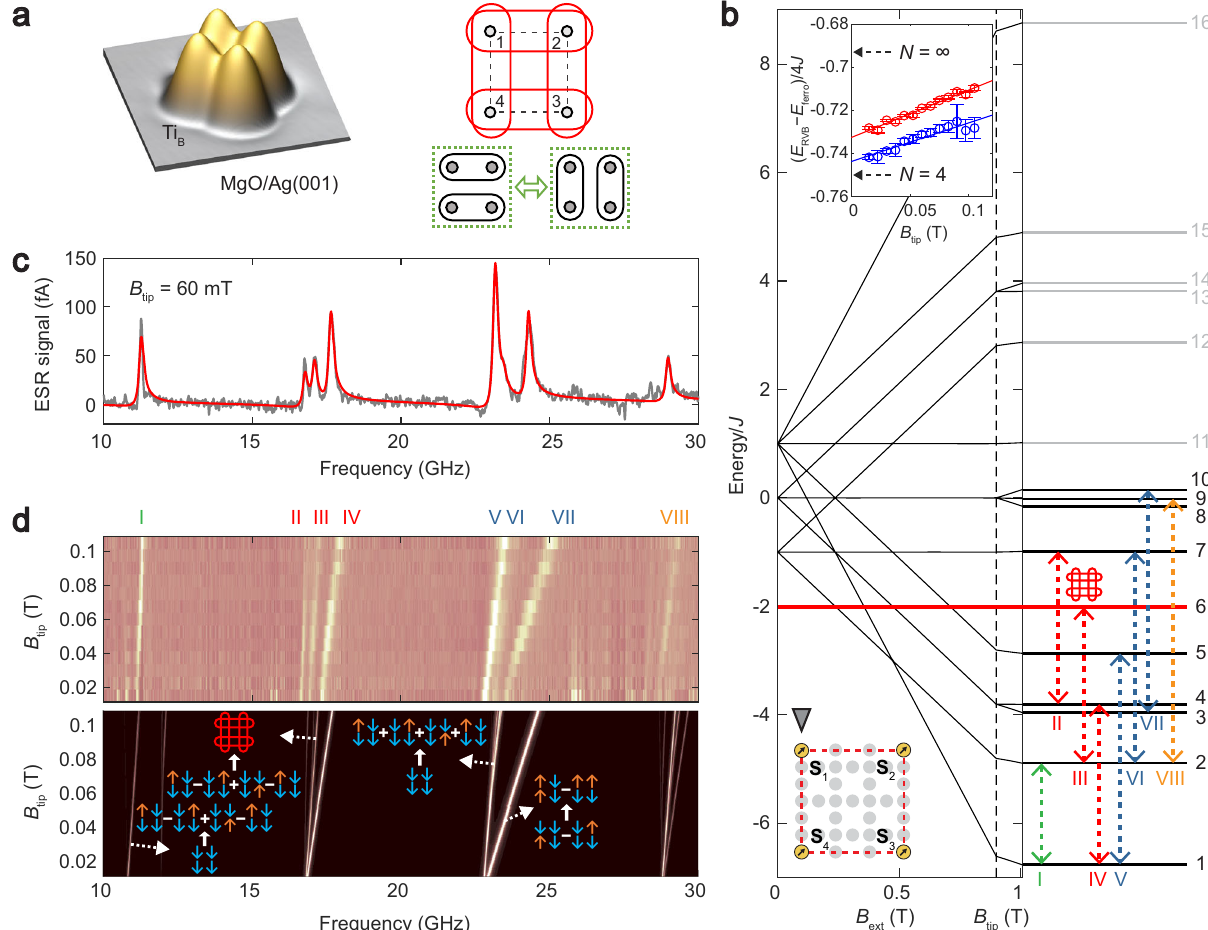
Fig. 4 RVB state in a spin plaquette. a STM image of a spin plaquette of Ti B atoms ( J ≈ 6 GHz). Right: Schematic of the RVB state (red) consisting of the superposition of two spin pairings (green). b Energy level diagram as a function of B ext and B tip . Dashed arrows indicate detected ESR transitions. Red line is the RVB state energy. Upper inset: energy per spin of the RVB state relative to the ferromagnetic state # 1 # 2 # 3 # 4 at B ext = 0, determined in two ways, by (cid:2) (cid:3) (cid:2) (cid:3) þ f (cid:2) 2 g μ þ f þ f (cid:2) f (cid:2) 2 g μ ¼ 0. Solid lines are linear fi ts. = 4 J (red circles) or f = 4 J (blue circles) and extrapolating to B measuring f B B I III ext II III IV VI ext tip B B Dashed arrows indicate the theoretical values for N = 4 spins and N = ∞ 28 at B tip ¼ 0. Error bars are from the fi tting uncertainties of the ESR frequencies with a 95% con fi dence. c ESR spectra taken on S 1 ( V DC = 50 mV, I DC = 200 pA, V RF = 8 mV, B ext = 0.9 T). Red curve is a fi t to a sum of asymmetric Lorentzian peaks. d ESR spectra as a function of B tip of the spin plaquette ( V DC = 50 mV, I DC = 50 – 350 pA, V RF = 3 – 13 mV, B ext = 0.9 T). Lower panel: Simulated ESR spectra. Blue and orange arrows represent spin-down and spin-up states, respectively. NATURE COMMUNICATIONS| (2021) 12:993